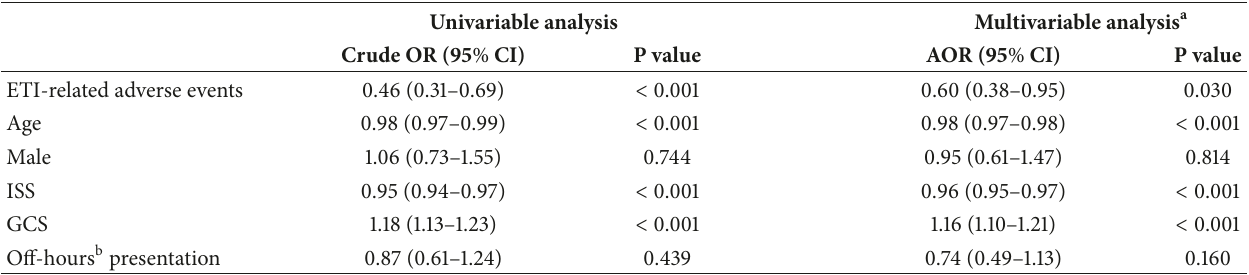
Table 4: Logistic regression models of factors associated with survival in trauma patients who received ETI in the prehospital setting or ED. Univariable